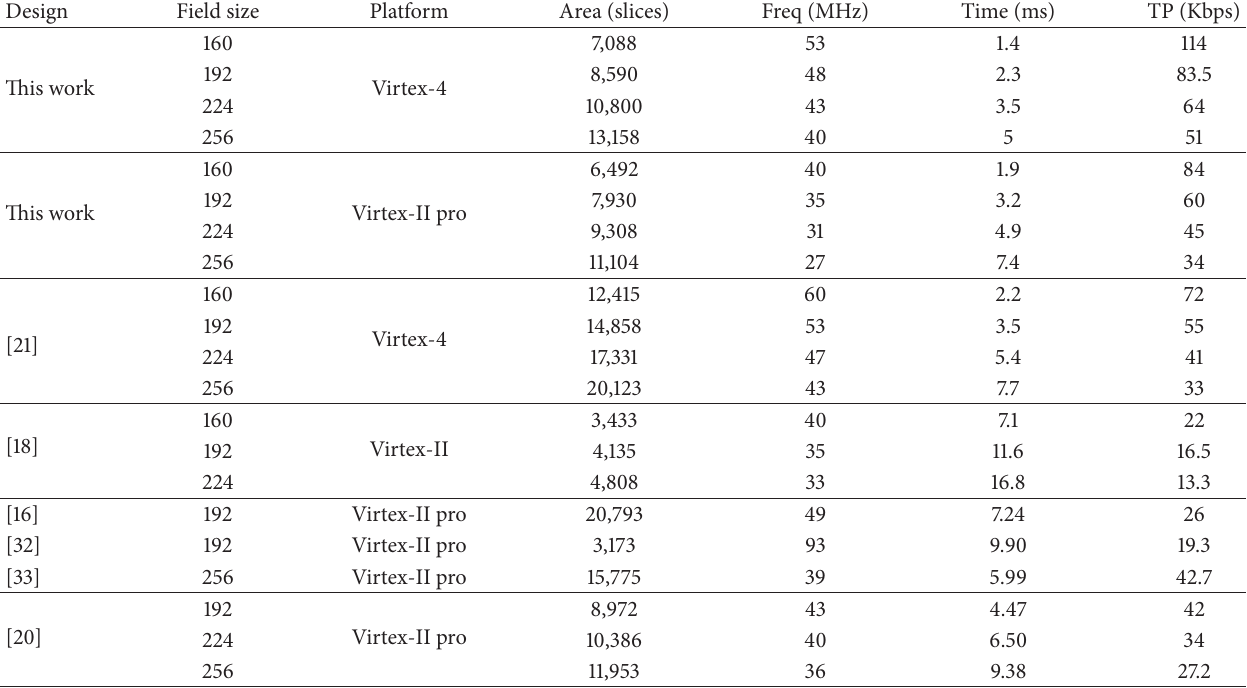
Table 5: Performance comparison with exiting FPGA